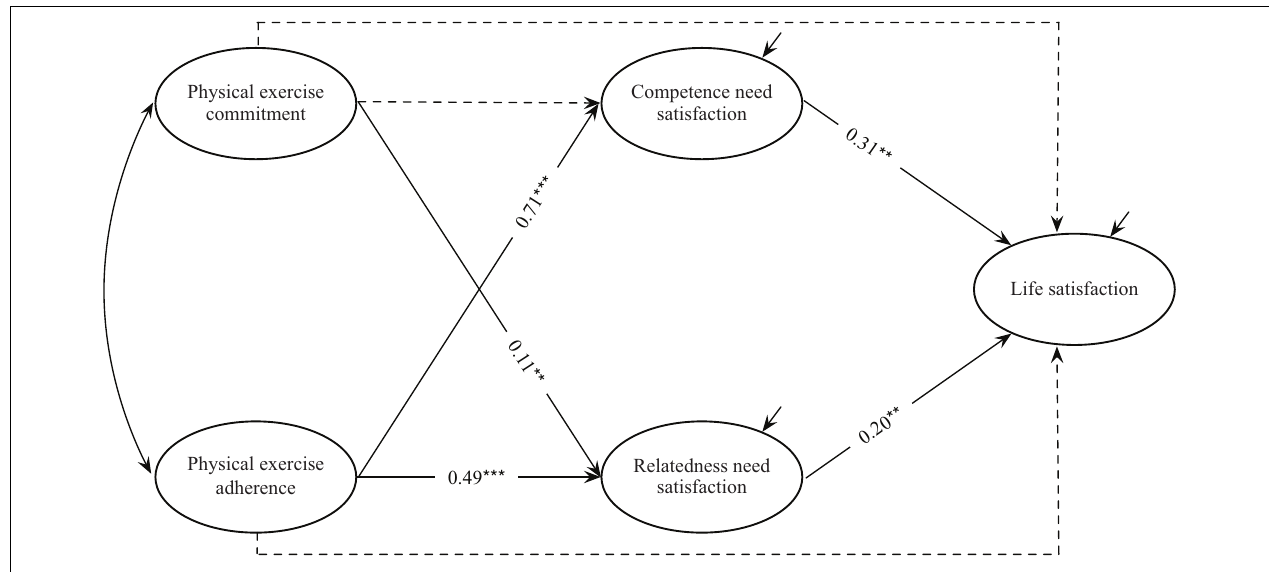
FIGURE 1 | Mediation model from physical exercise to life satisfaction. ** p < 0.01, *** p < 0.001; Dashed lines indicate non-significant coefficient. TABLE 2 | The results of mediation analysis using bootstrap. Pathways All